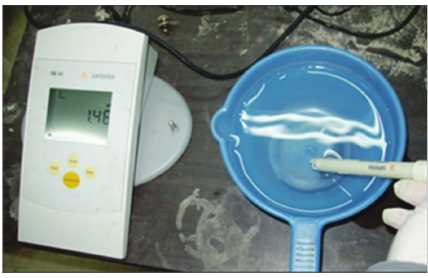
Figure 5: PB-10 Sartorius Acidometer.